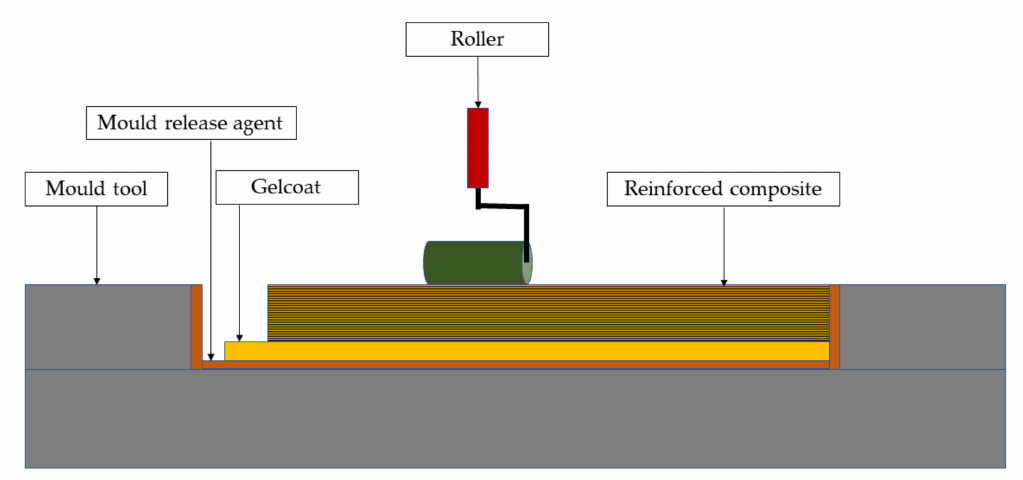
Figure 1. Scheme of the hand lamination